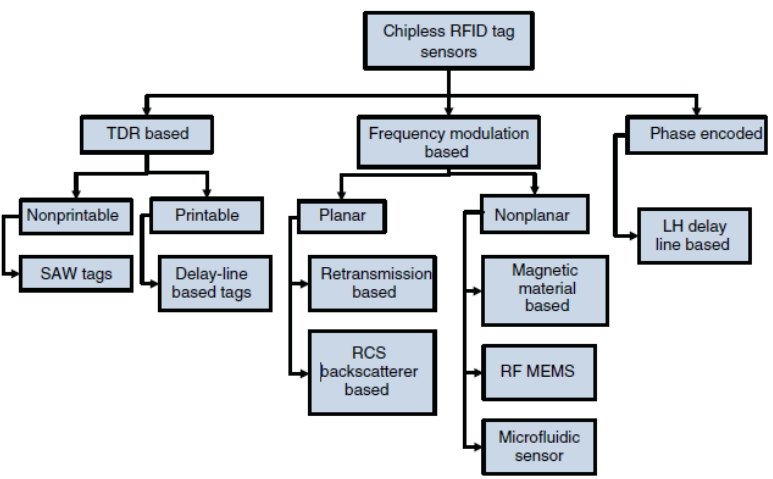
Figure 1. Types of chipless RFID tags (Reprinted with permission from Ref. [25] 2016, John Wiley and Sons) .